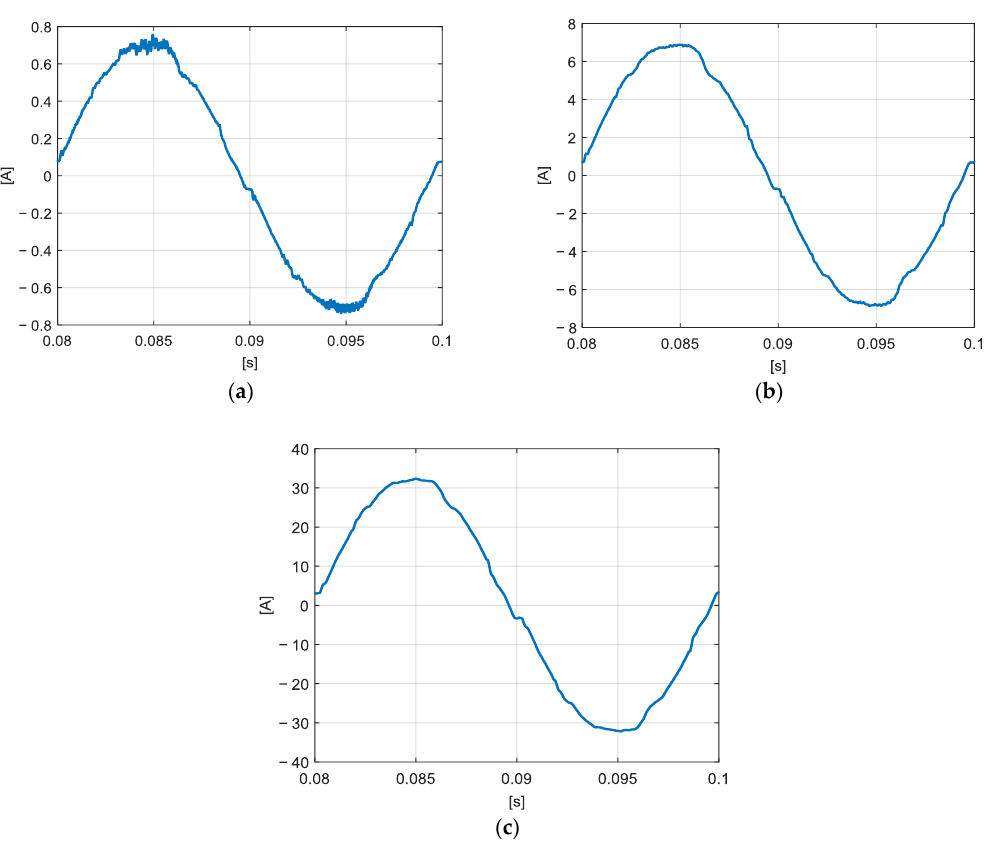
Figure 46. Case study 4: time trends of the waveforms under study, measured for ( a ) one lamp, ( b ) ten lamps, and ( c ) forty-eight lamps.